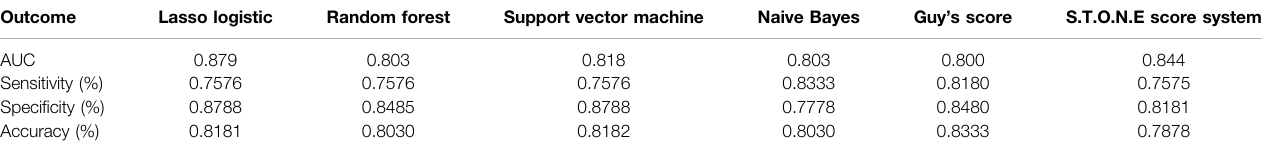
TABLE 3 | AUC, sensitivity, speci fi city, and accuracy of each prediction method for the results of the stone-free status. Outcome Lasso logistic